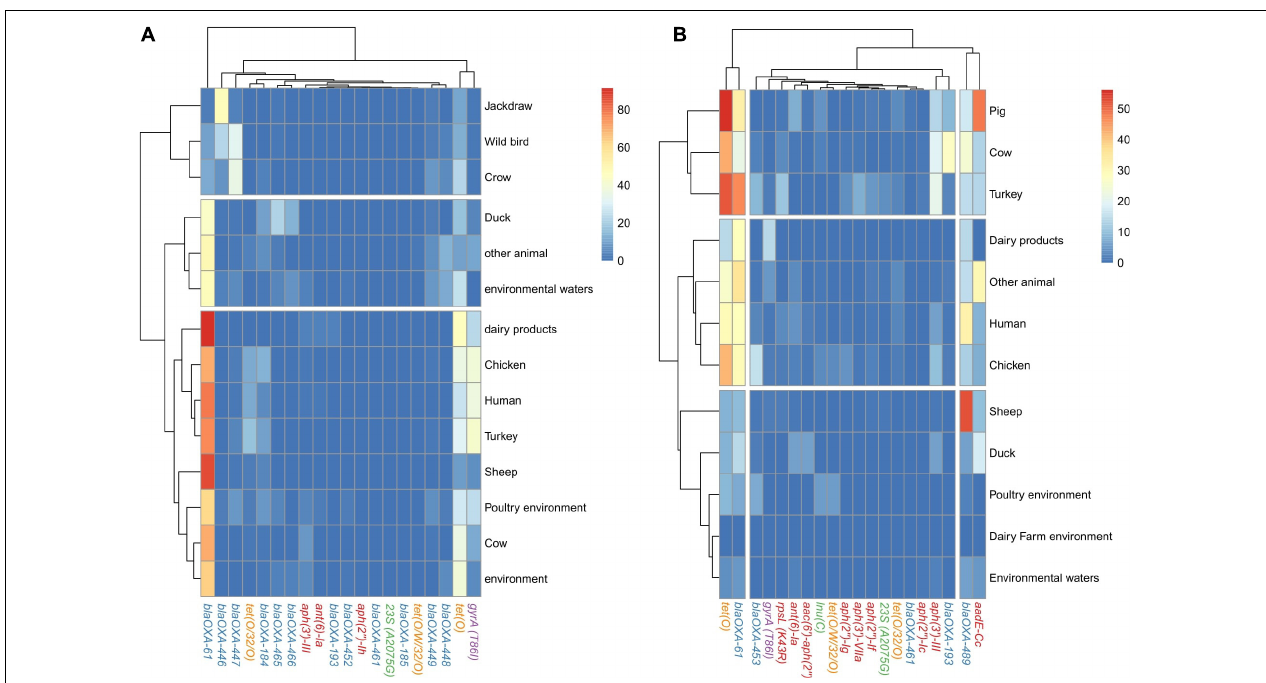
FIGURE 5 | AR genes and SNP distribution among C. jejuni and C. coli genomes by source of isolation. Heatmap plot showing the percentage of (A) C. jejuni genomes and (B) C. coli genomes per isolation source carrying ARGs or SNPs associated with AR, showed in columns. Only the main 20 ARGs or SNPs are presented, because the clustering by isolation source remained the same as when the 120 and 68 AR determinants were used for C. jejuni and C. coli , respectively (data not shown). Only isolation sources containing more than 50 genomes are presented. Gene names are colored according to the corresponding antimicrobial family (blue: beta-lactams, orange: tetracyclines, red: aminoglycosides, purple: quinolones, and green: MLSP).